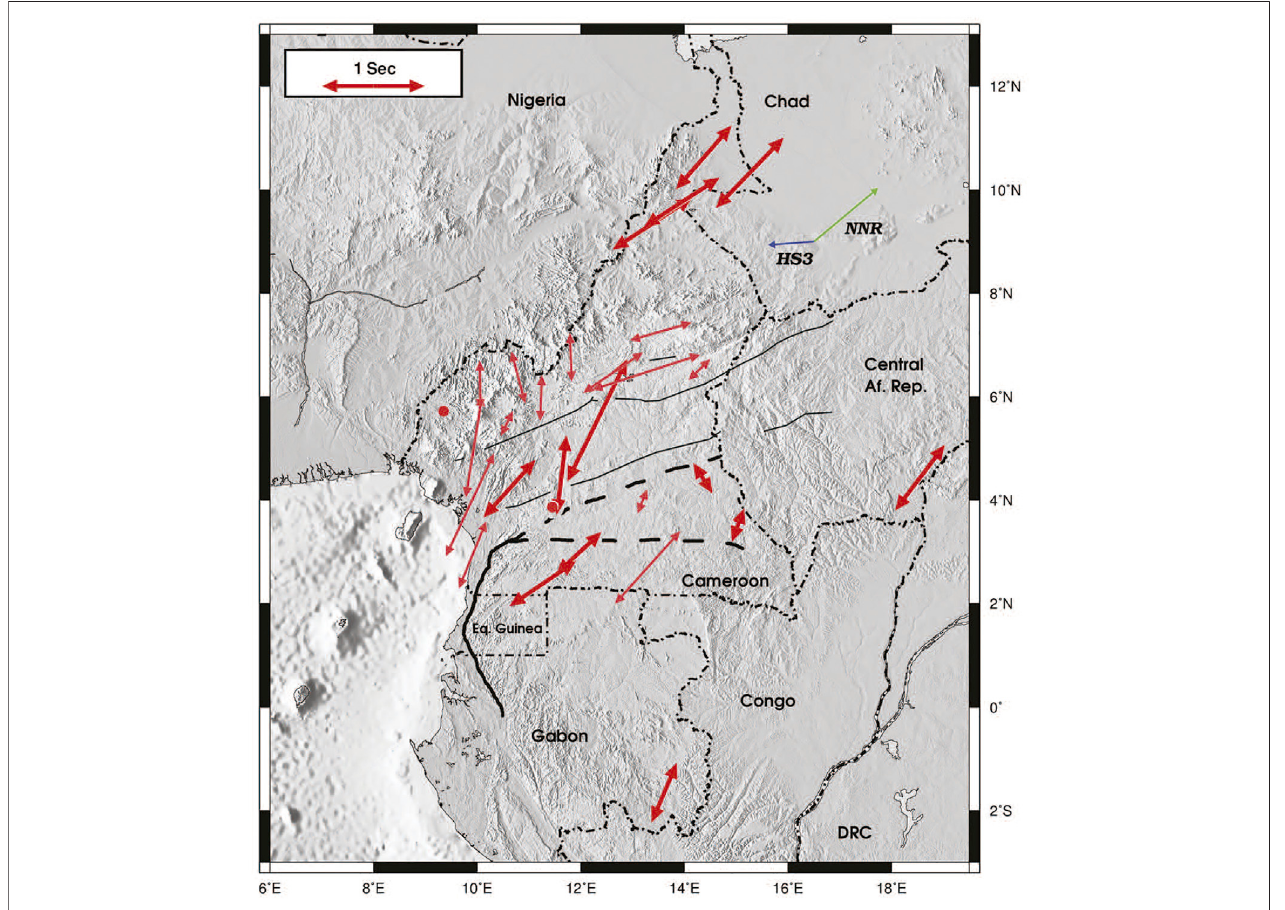
FIGURE 7 | Fast directions and delay times from shear wave splitting for stations from the CBSE. Reproduced with permission from Koch et al. (2012).